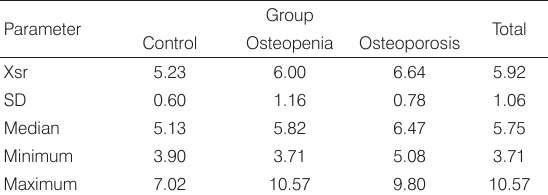
Table 1. Cholesterol level in patients by group